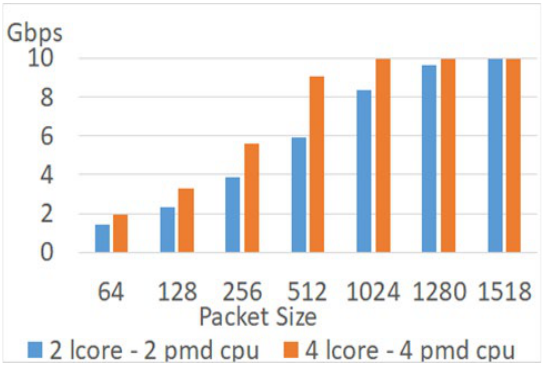
Figure 18. Throughputs of OVS-DPDK when lcore and pmd-cpu increase.